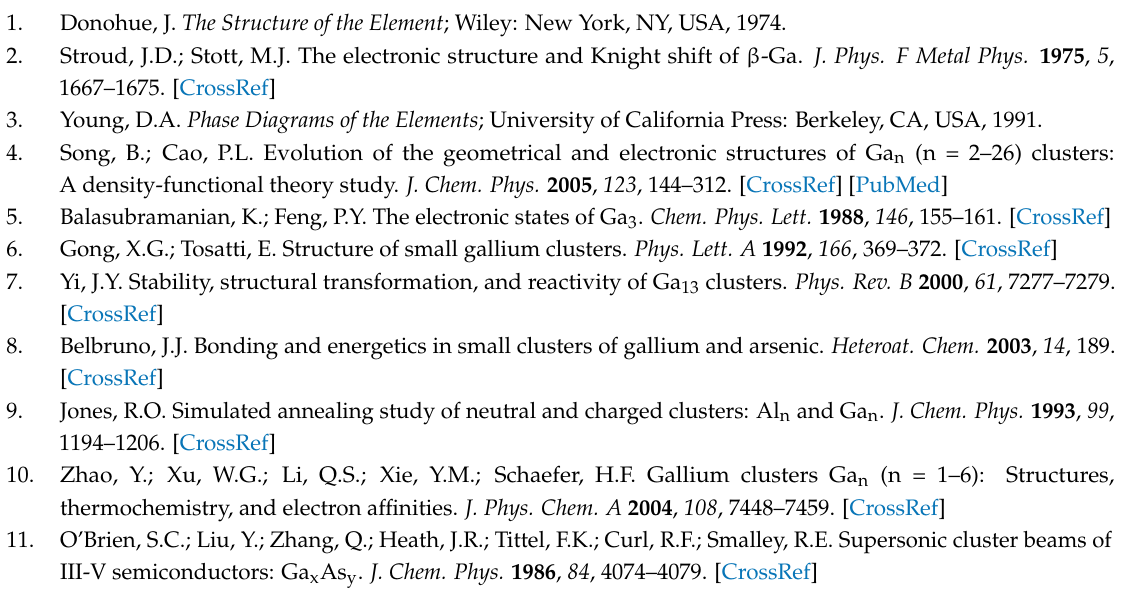
Figure S1: The orbital composition of HOMO and LUMO for Ga 5 X (X = B, C, N, O, F, Al, Si, P, S, Cl)